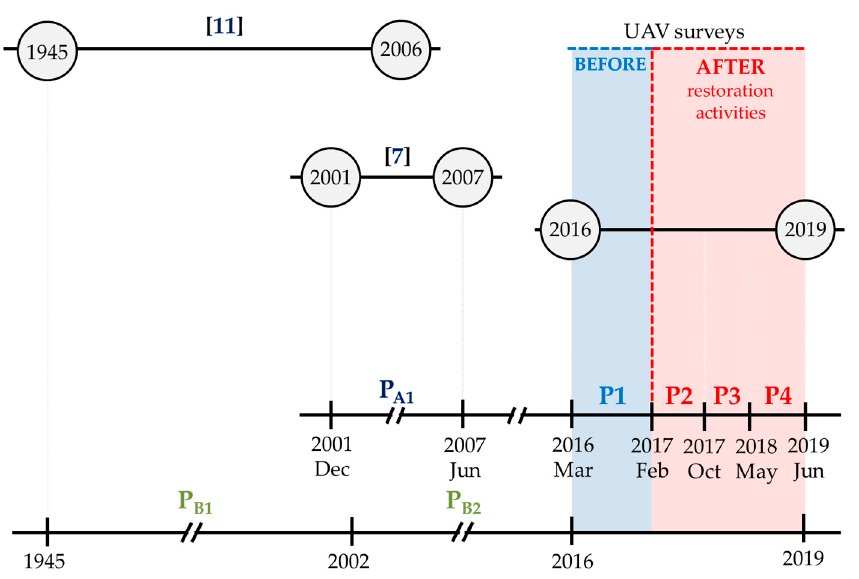
Figure 2. Time periods considered in the study as a result of the availability of topographic data. The vertical red line displays the date of the restoration measure implementation.